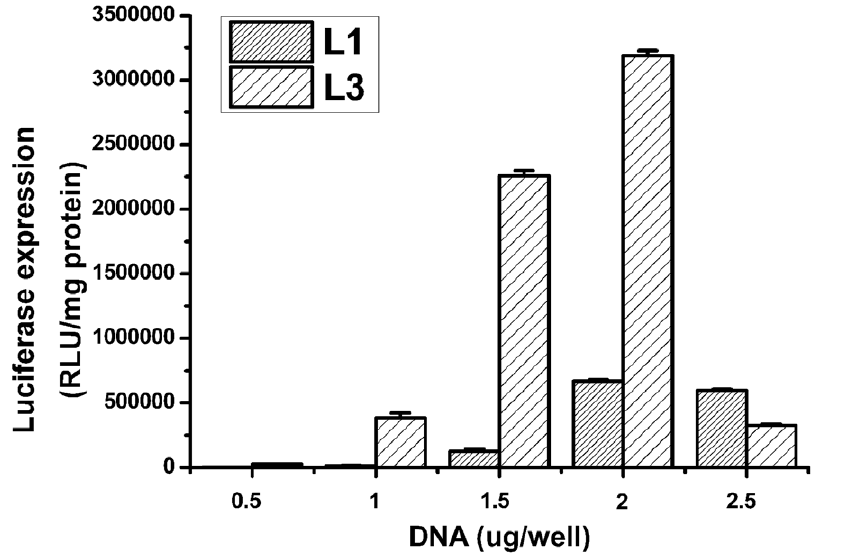
Figure 9. Transfection efficiencies of L1 and L3 at various amount of DNA using optimized lipid/DOPE ratio of 1 :2 (for L1 and L3) and optimized N/P ratio of 2 (for L1) and 10 (for L3) in A549 cells. Data are expressed as relative light units (RLU)/mg of protein.